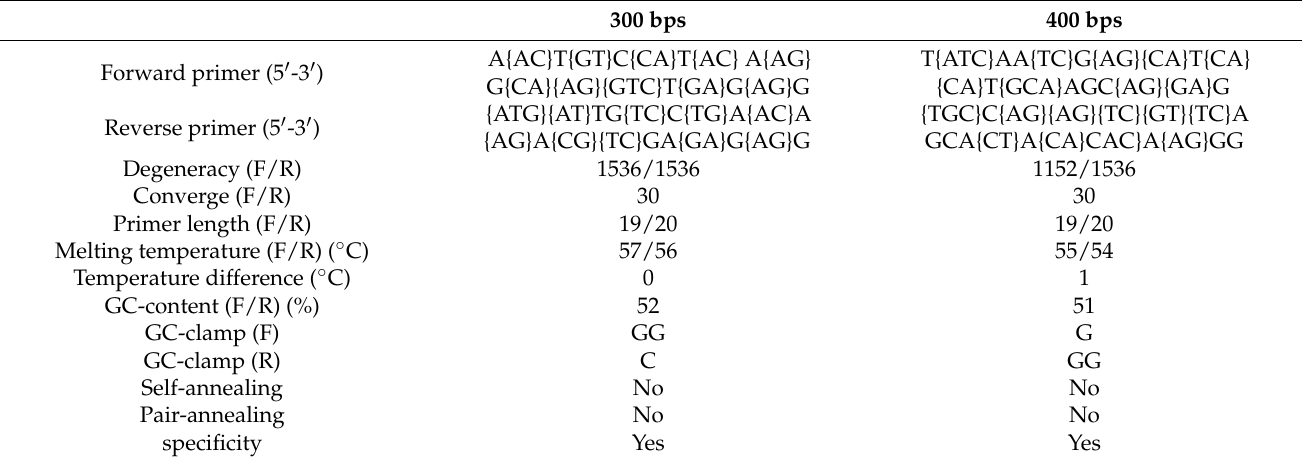
Table 5. Experimental results for the 300 bps and 400 bps DNA templates. 300 bps 400